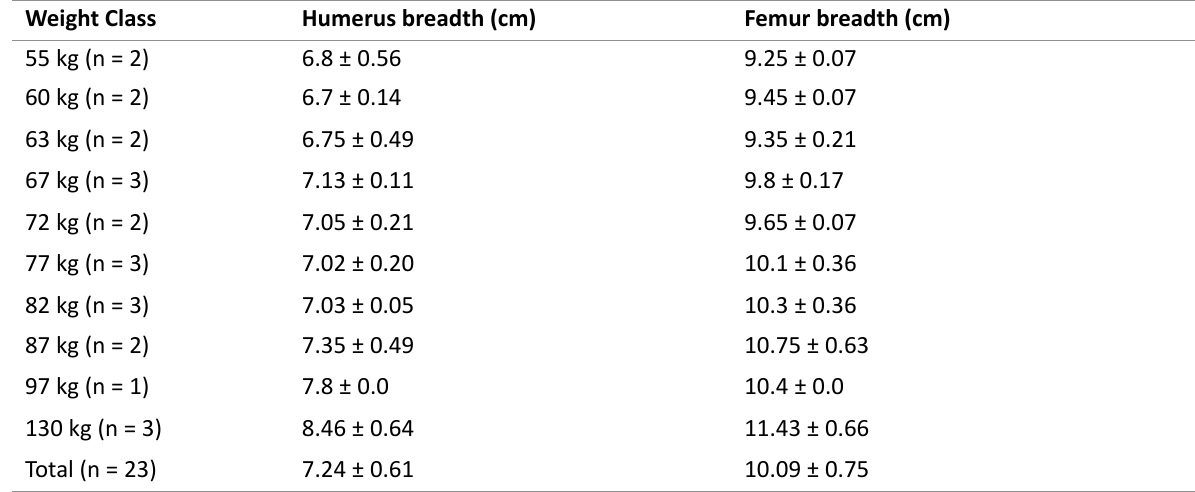
Table 4. Mean and standard deviation of breadth of the elite Azerbaijani senior Greco-Roman wrestlers Weight Class